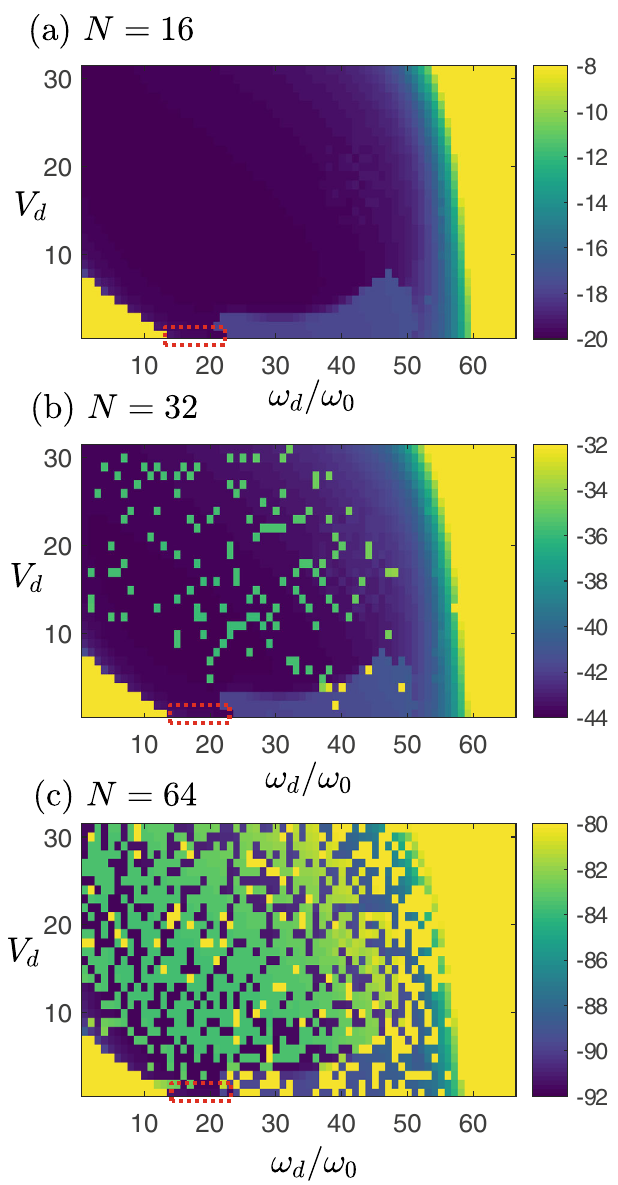
Fig. 9 Visualizing computing ef fi ciency ’ s dependence on network size. Dependence of the network ’ s fi nal energy on the driving frequency ω d and the driving amplitude V d for Möbius-ladder networks of increasing sizes: a N = 16 with E ð th Þ min ¼ (cid:2) 20, b N = 32 with E ð th Þ min ¼ (cid:2) 44 and c N = 64 with ¼ (cid:2) 92. The dashed red box marks a region of the parameter space E ð th Þ min which appears to be most robust with respect to the increment of the network